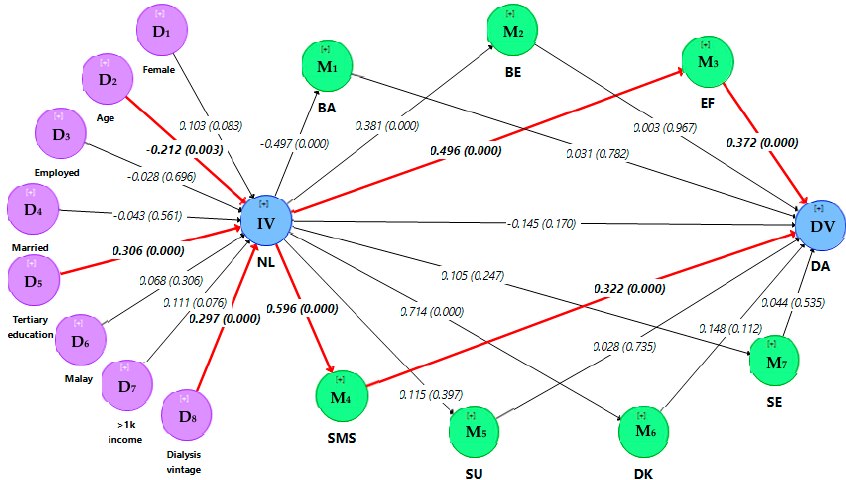
Figure 2. Bootstrapping result for serial mediation analysis (5000 resamples and 2-tailed). The figure shows the full relationship continuum from sociodemographic factors and dialysis vintage to nutrition literacy, patient-related factors and finally dietary adherence in HD patients. Significant mediation paths are highlighted by red bold lines. Data are presented as path coe ffi cient for the direct e ff ect ( p -value); NL: